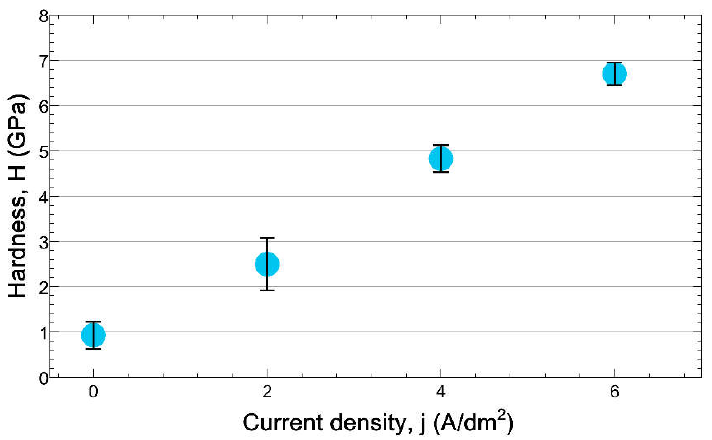
Figure 8. Indentation curves obtained on the cross-section of an anodized sample anodized at dif- ferent current densities for 1 h.